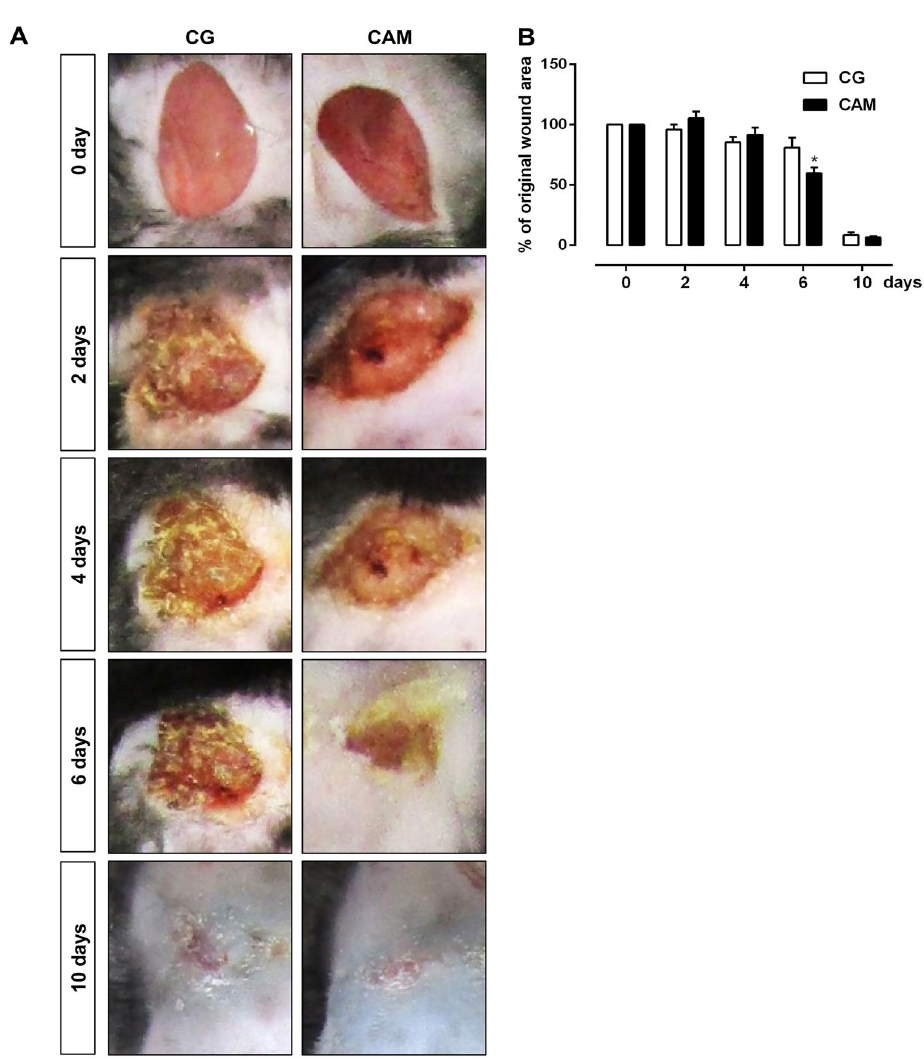
Figure 2. Macroscopic changes. A , Macroscopic changes in skin excisional wounds during wound closure in the control (CG) and chitosan and alginate membrane (CAM) groups, 0, 2, 4, 6, and 10 days post-wounding. B , Percentage of initial lesion area in the CG and CAM groups. Data are reported as means ± SE of 5 animals per group. *P o 0.05 vs CG